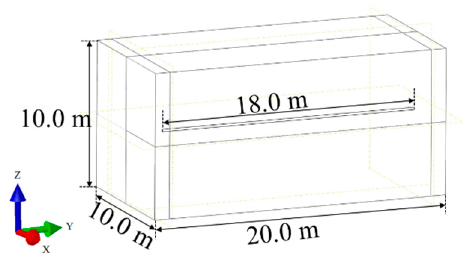
Figure 2. Reservoir model size.